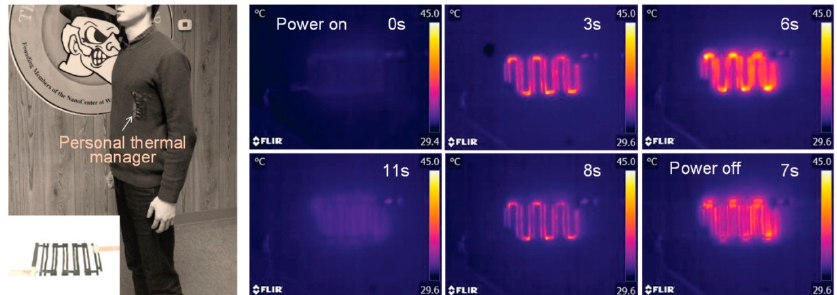
Figure 10. A demonstration of wearable rGO films for personal thermal management. The rGO films possessed kirigami structure and were integrated into cloth. A work cycle of heating–cooling can be implemented within 11 s. Reprinted from [22] with permission; Copyright 2017 Wiley Online Library.